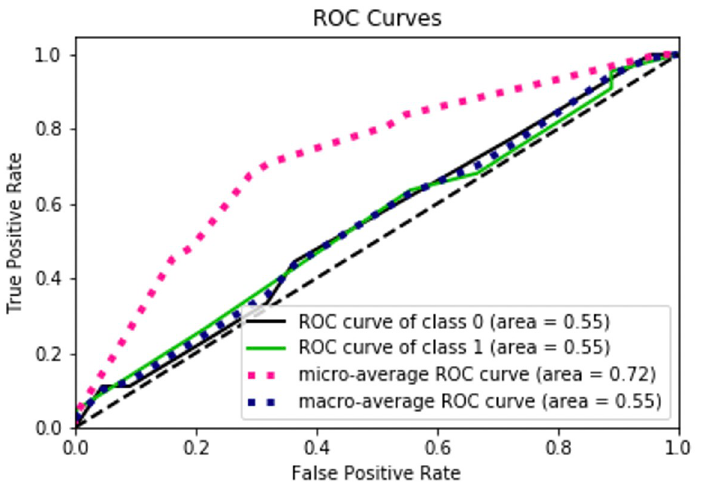
Fig 9. Graph of the Area Under the Curve—Receiver Operating Characteristic curve, generated by Scikit-plot. By default, the curve algorithm splits the ROC Curve into three parts. The ROC curve by the classes, the micro-average of the ROC Curve, and the macro-average of the ROC Curve. The micro-average shows that the model predicts better than a random assignment of papers to models.